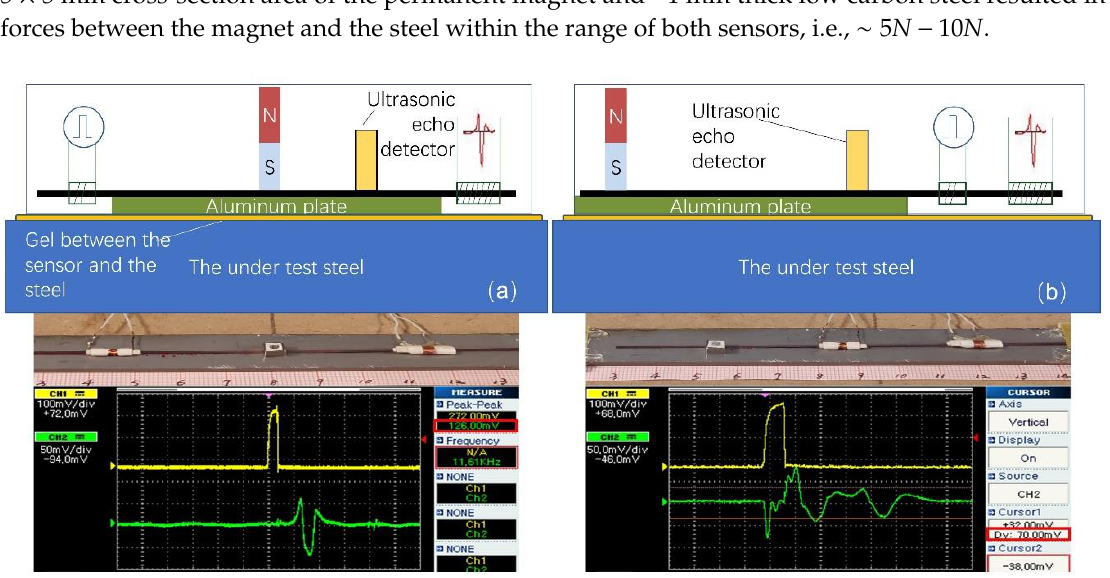
Figure 4. The force-permeability sensor based on the magnetostrictive delay line (MDL) principle: ( a ) the force sensor monitors the permeability changes as a result of the distortion of elastic propagating waves, observed by the decrease of the Vo with the exerted force; ( b ) the sensor monitors the permeability changes as a result of the reflections generated in the volume where the permanent magnet is pressing the MDL, observed by the Vo of the second detected pulse, corresponding to the reflection mentioned above.